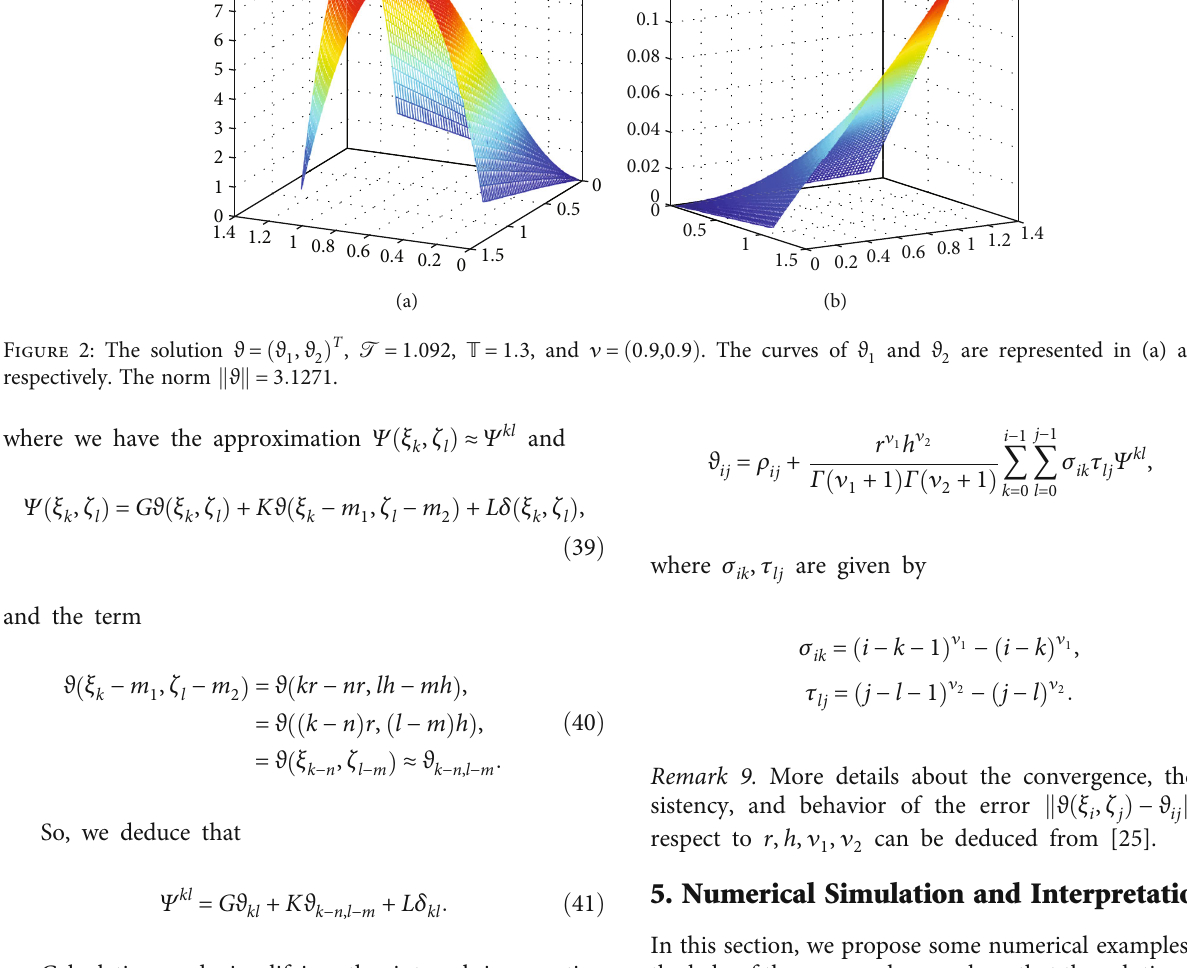
ϑ 1 and 2 are represented in (a) and (b), respectively.